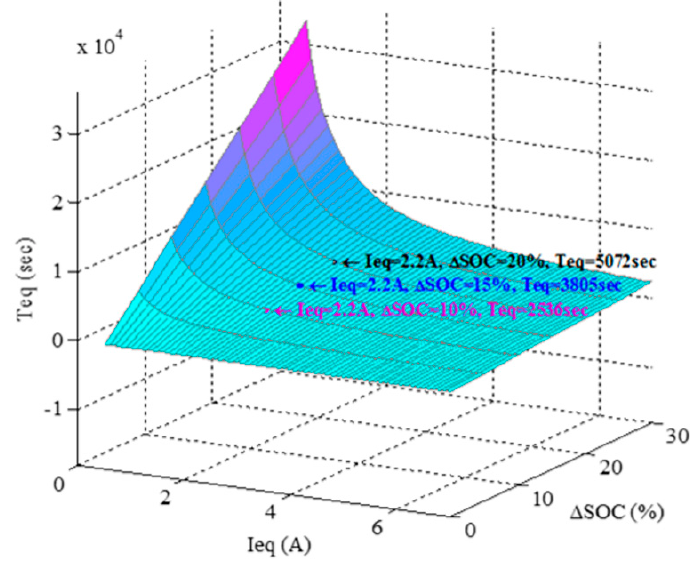
Figure 12. Charge equalization control surface model for battery discharge.